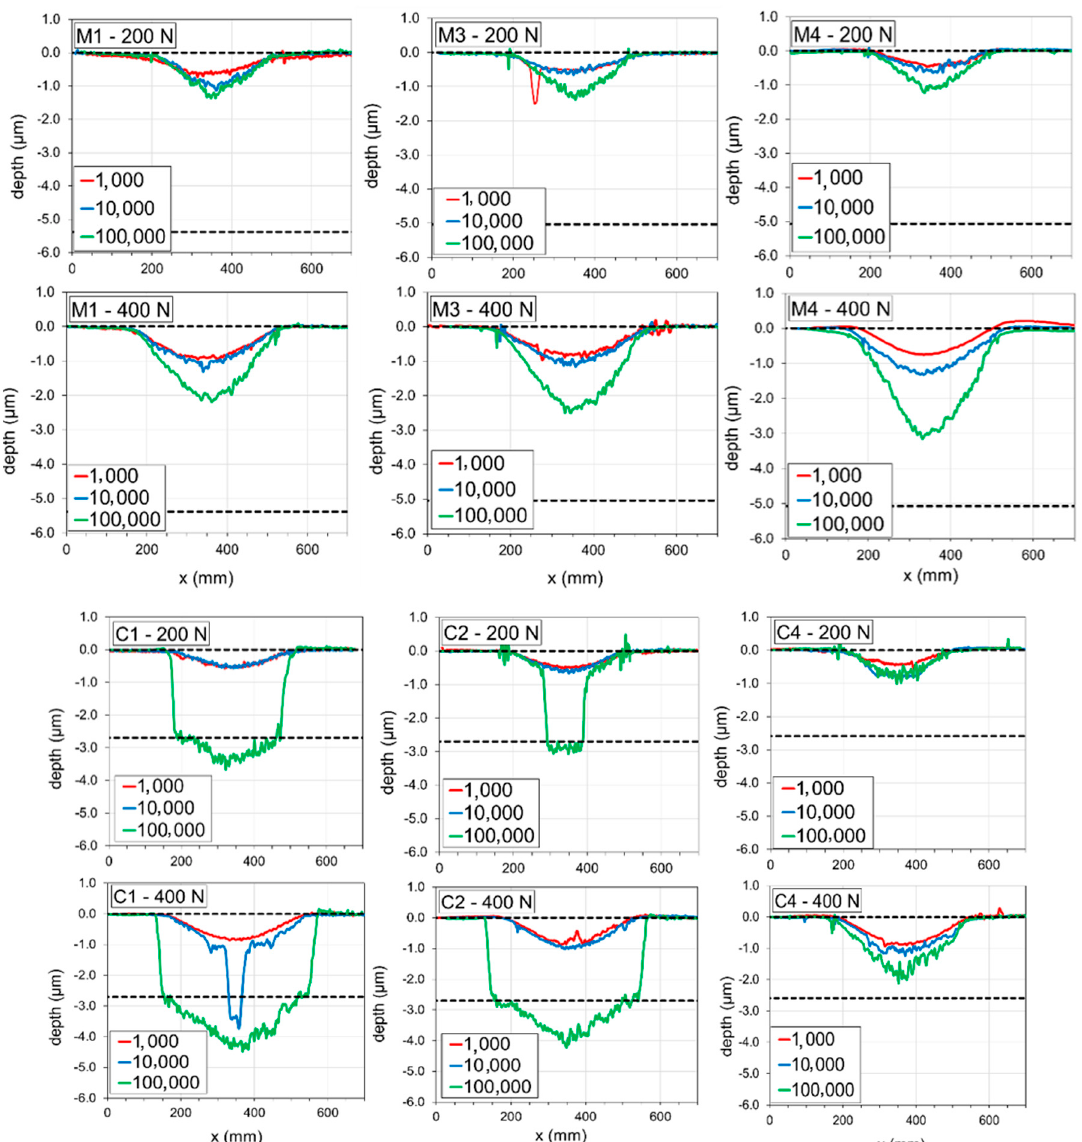
Figure 6. Cross-section profiles of impact craters after different impact cycles on AlCrN coatings. Horizontal dashed grey lines denote the position of the surface of coatings and the coating/substrate